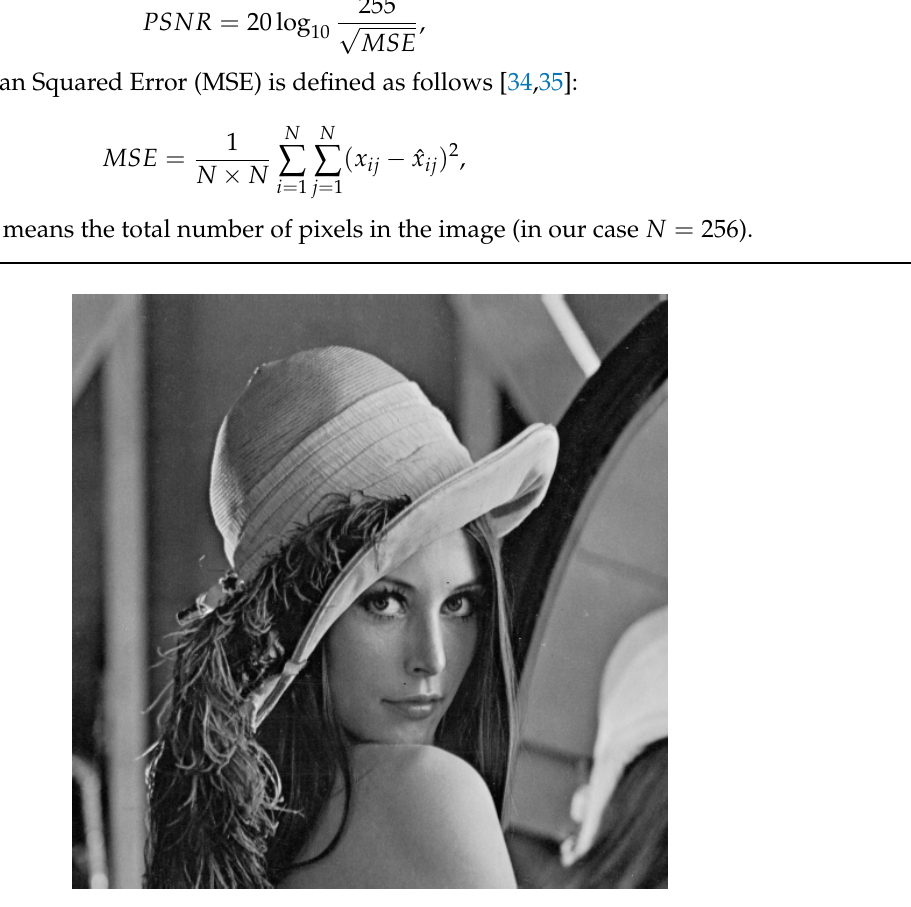
Figure 4. Image Lena.bmp (see https://www.cosy.sbg.ac.at/$\sim$pmeerw/Watermarking\/lena. html, accessed on 14 July 2022).